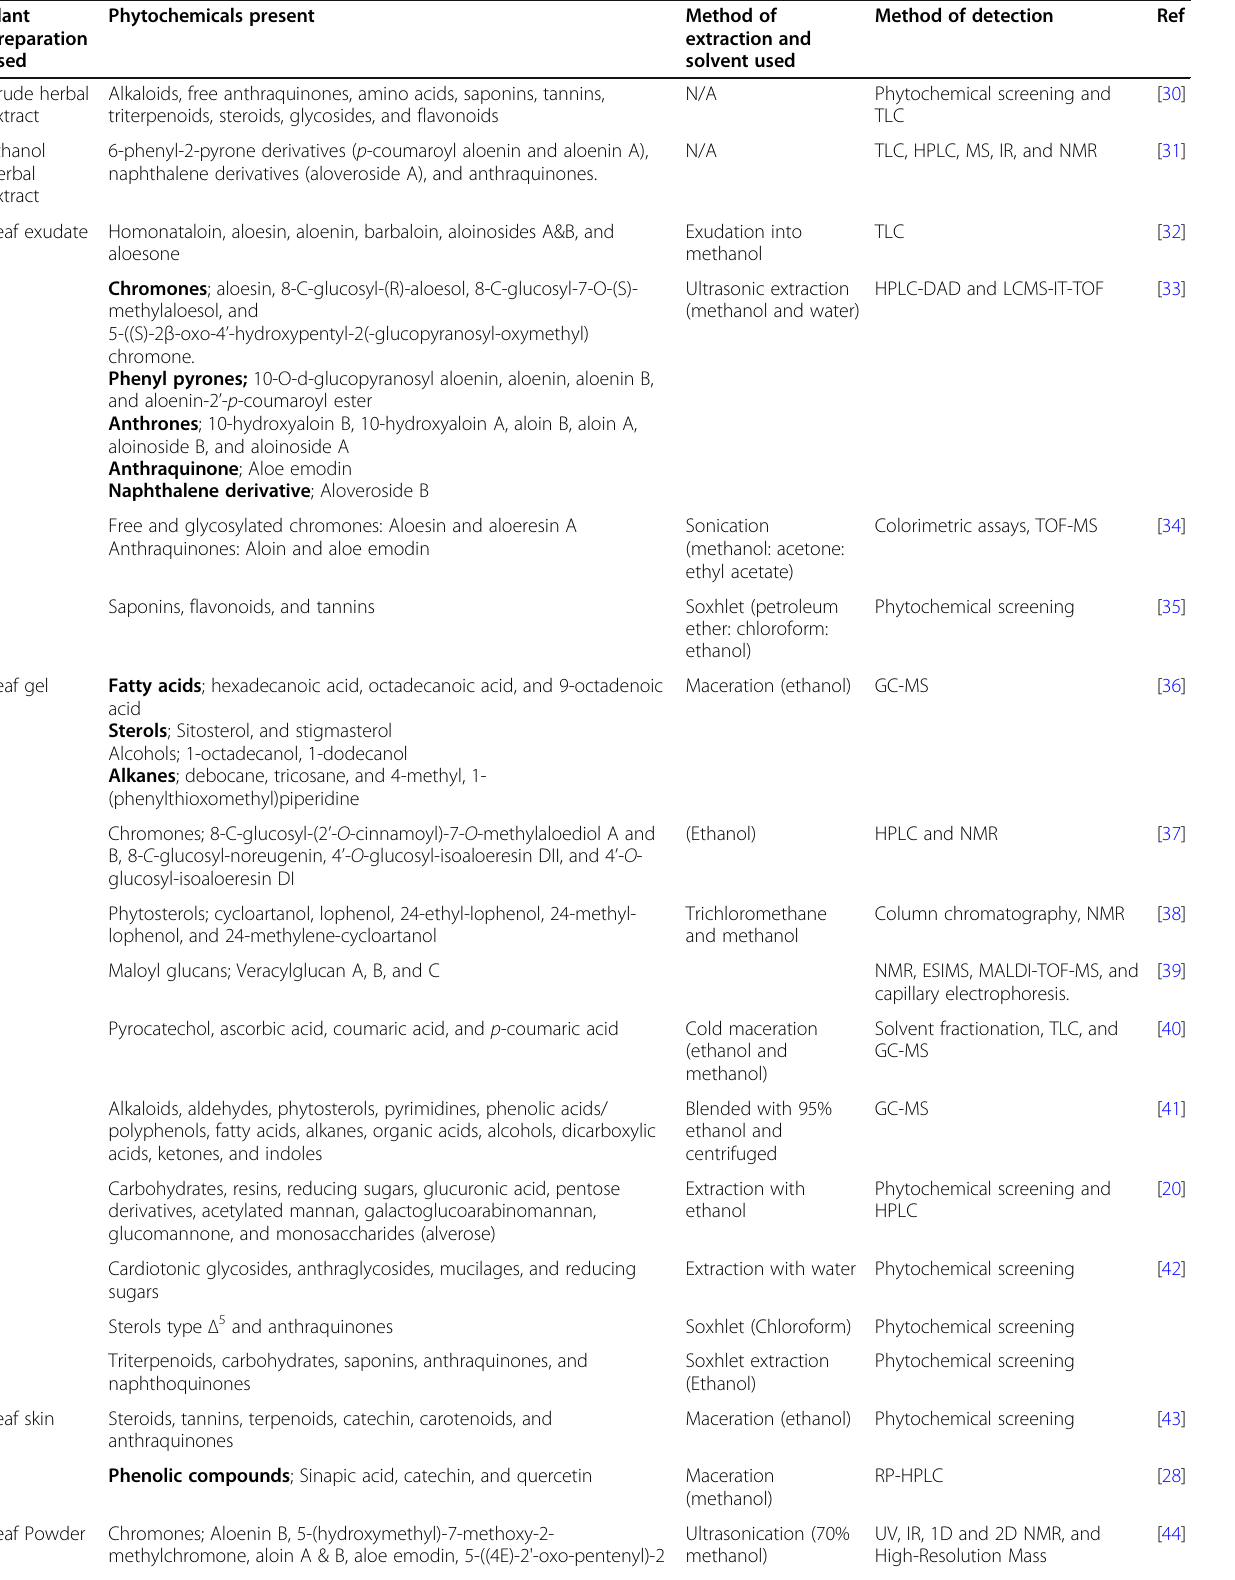
Table 2 Phytochemical profile of the gel, skin, powder, and extracts from A. vera leaves Plant preparation